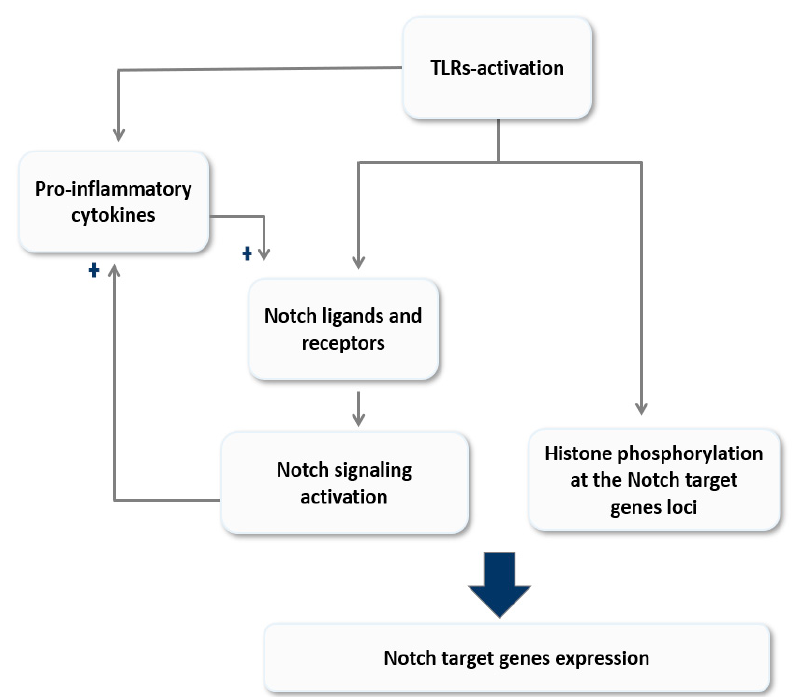
Figure 2. A model of reciprocal modulation of Notch signaling and Toll-like receptor